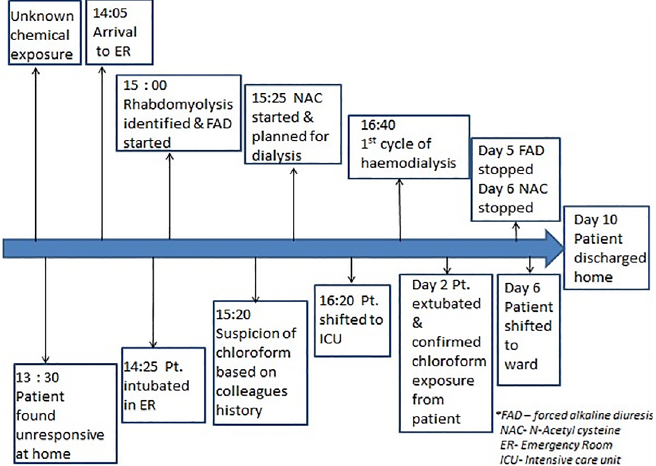
Figure. Timeline of our management of patient with chloroform toxicity. ER , emergency room; Pt , patient; NAC , N-acetyl cysteine; ICU , intensive care unit; FAD , forced alkaline diuresis.